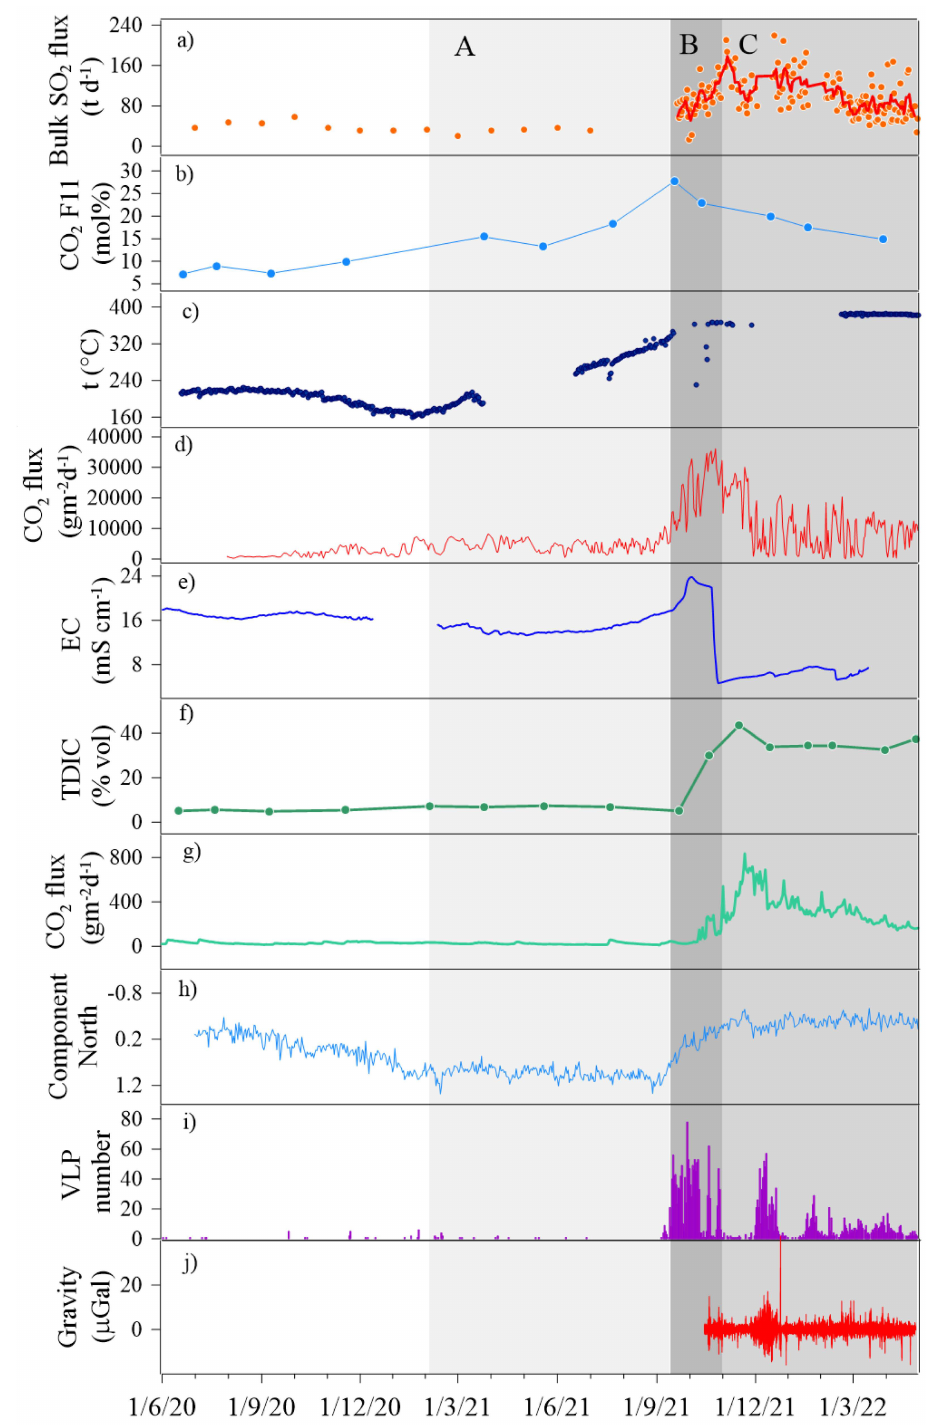
Figure 21. Time trends of ( a ) SO 2 flux, ( b ) CO 2 content in the fumarole F11, ( c ) outlet temperature in the fumarole TK2, ( d ) soil CO 2 flux in the crater southern rim (site Bordosud), ( e ) EC referred at 20 ◦ C in the Camping Sicilia well, ( f ) TDIC in the Camping Sicilia well, ( g ) soil CO 2 flux in the site C. Sicilia, ( h ) GPS component north of the SLT station, ( i ) daily occurrence rate of seismic events with frequency peak < 1 Hz, ( j ) gravity signal observed at VPORT